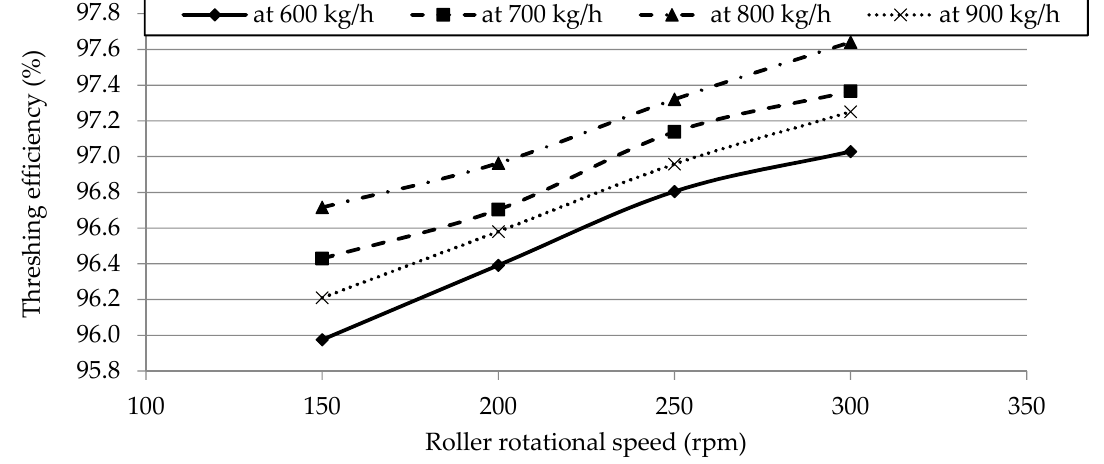
Figure 5. Effect of the roller’s rotational speed (rpm) on the unthreshed seed percentage (%) at different feed rates (kg/h). 3.3. Effect of the Roller’s Rotational Speed on the Threshing Efficiency at Different Feed Rates